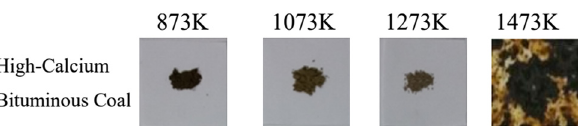
Description of sample